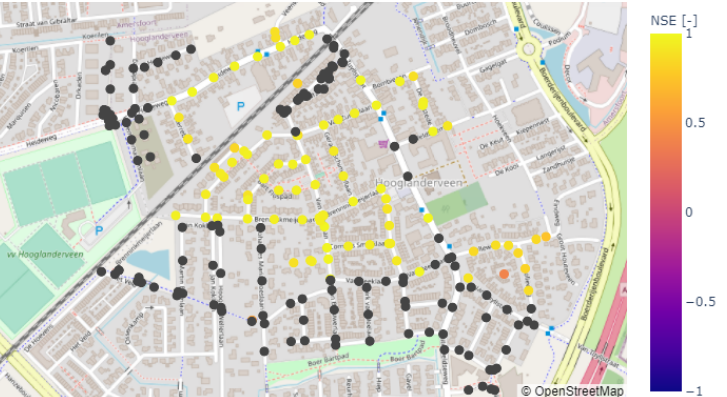
Figure 10. The NSE values for each manhole in the case study area that experienced flooding from the validation data set (NSE = 0.92). The NSE values were calculated with the predicted flood volume time series by the LSTM network and sewer model. The NSE is calculated for each time series and a mean is taken for each manhole. Dark grey manholes indicate locations where no flooding